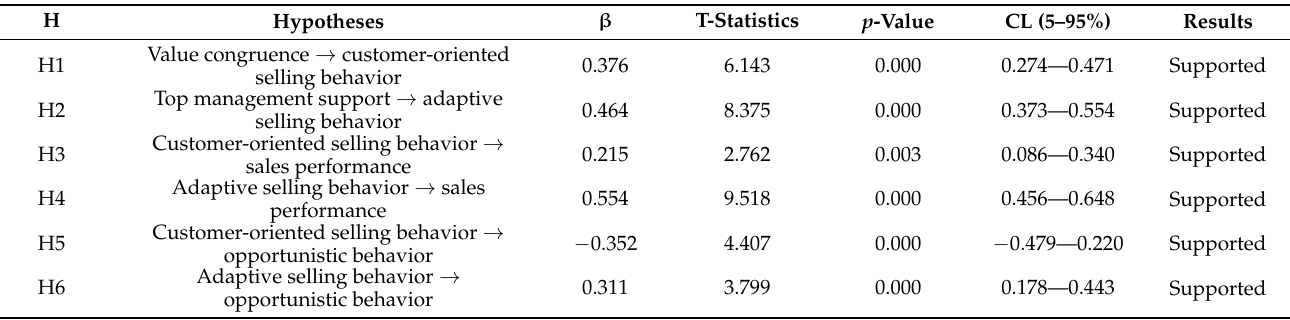
Table 6. Results of the structural